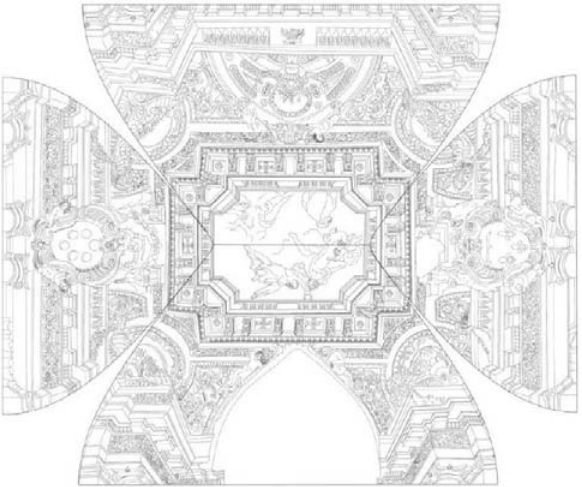
Figure 7 – Unfolding of paintings represented on the vault of the House of Justice of the Pitti Palace (Florence, Italy).